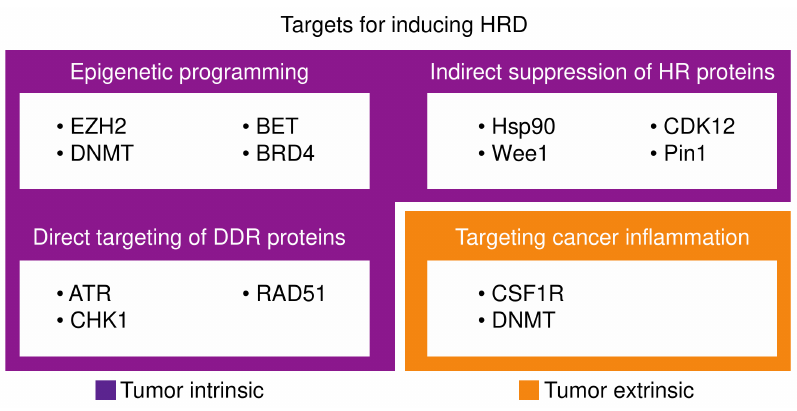
Figure 2. Targets for inducing homologous recombination deficiency